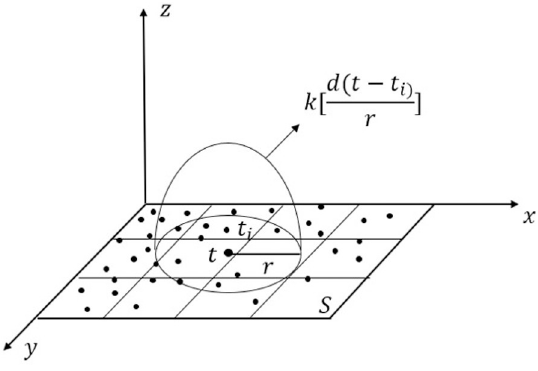
Fig 4. Spatial kernel density